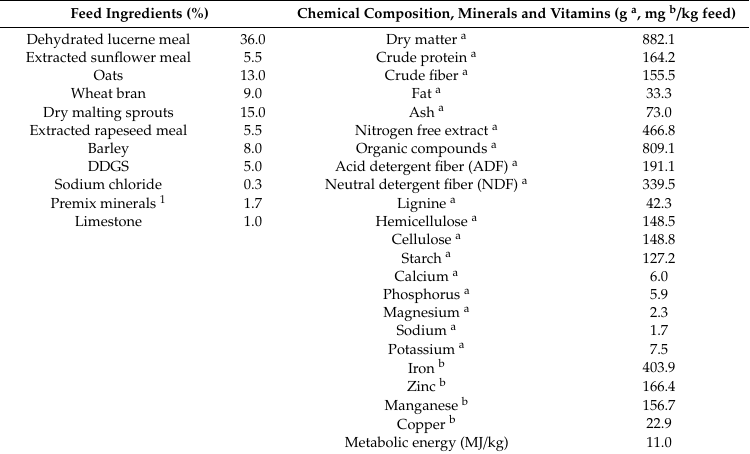
DDGS: Dried distillers grains with solubles. a Ingredients in g / kg feed; b Ingredients in mg / kg feed; 1 Premix contains per kg: Calcium 6.73 g; phosphorous 4.13 g; magnesium 1.90 g; sodium 1.36 g; potassium 11.21 g; iron 0.36 g; zinc 0.13 g; copper 0.03 g; and selenium 0.2 mg. Vitamin mixture provided per kg of diet: Vitamin A 1,500,000 IU; Vitamin D3 125,000 IU; Vitamin E 5000 mg; Vitamin B1 100 mg; Vitamin B2 500 mg; Vitamin B6 200 mg; Vitamin